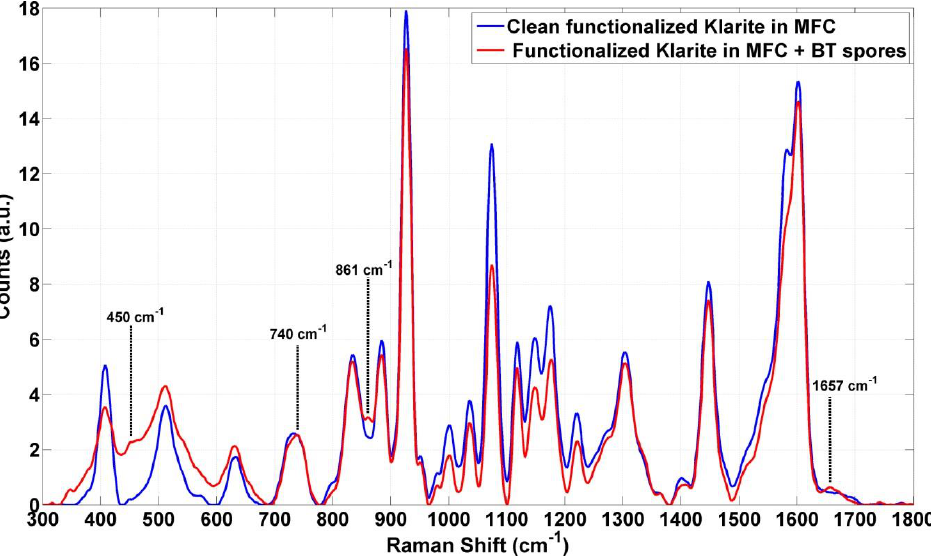
Figure 3. The average of the SERS spectra acquired on the clean cartridge (blue lines) compared to substrate inoculated with Bacillus thuringiensis endospores (SBT) (red lines).